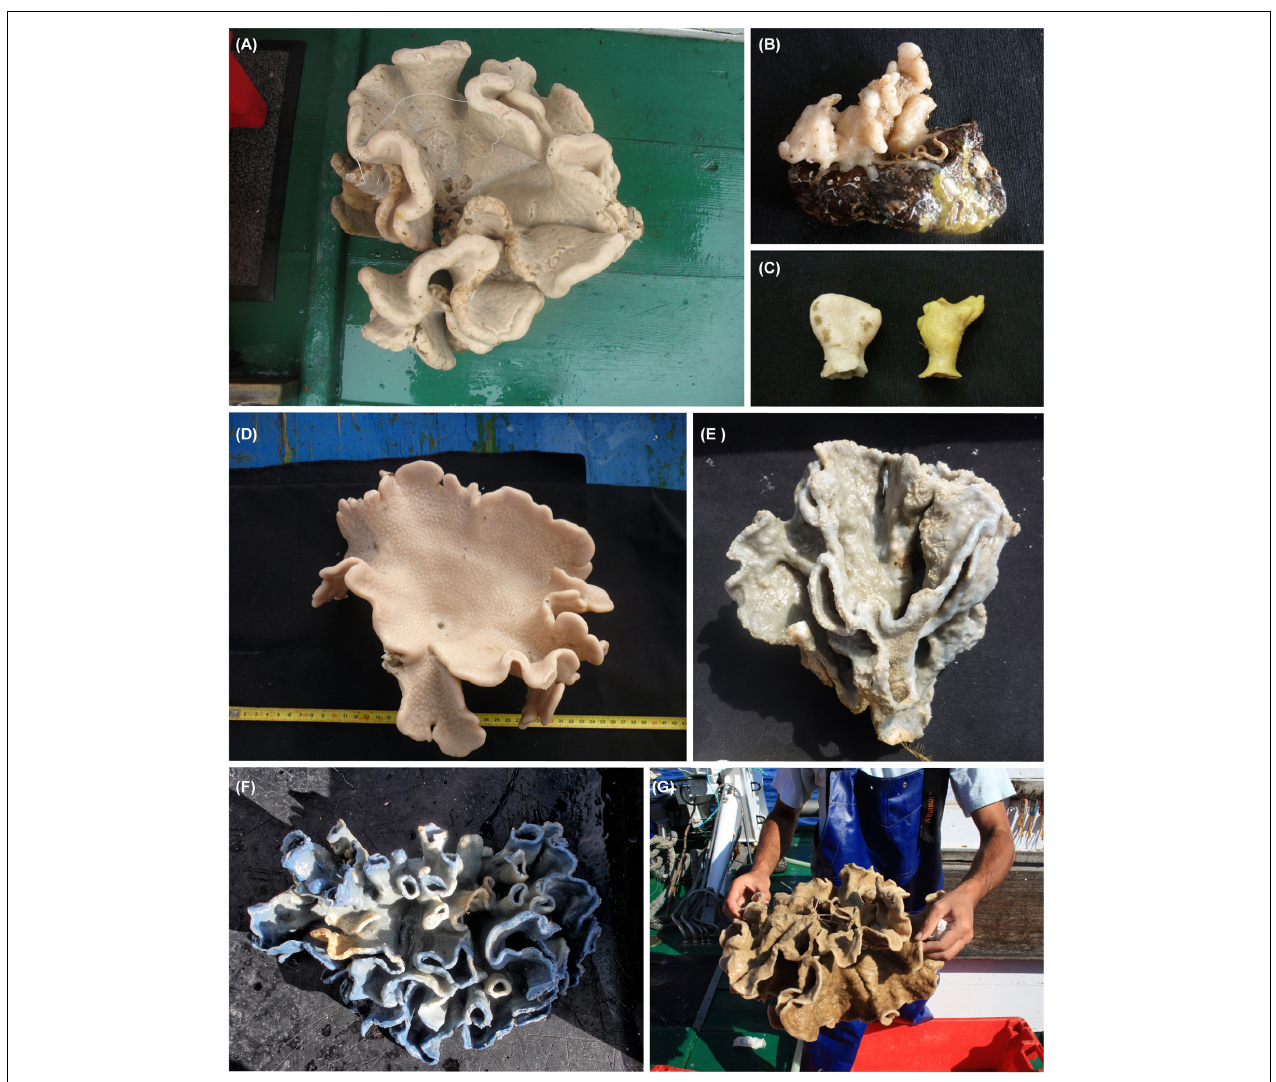
FIGURE 2 | Example of lithistid sponges of the Azores, collected and analyzed in the present study. (A) Neophrissospongia nolitangere (DOP 5323), (B) Discodermia ramifera (DOP 6477), (C) Exsuperantia archipelagus (DOP 6212), (D) Macandrewia azorica (DOP 6601), (E) Leiodermatium cf. lynceus (DOP 6429), (F) Leiodermatium cf. pfeifferae (DOP 11102), (G) Leiodermatium tuba (DOP